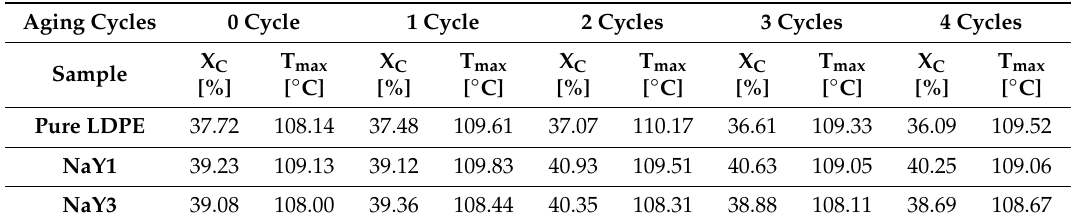
Table 1. Crystallinity and melt peak value of pure LDPE and zeolite / LDPE nanocomposites at di ff erent thermal aging cycles. Aging Cycles 0 Cycle 1 Cycle 2 Cycles 3 Cycles 4